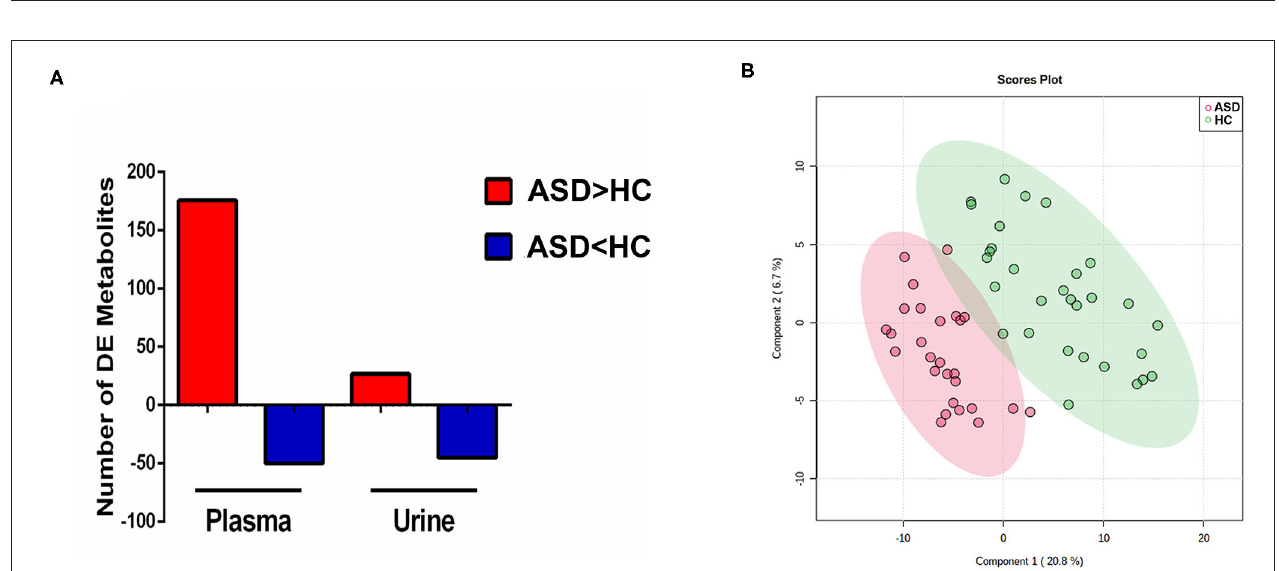
FIGURE 2 | Discriminating metabolites and partial least squares discrimination analysis (PLS-DA). (A) Number of discriminating (DE) metabolites between groups in plasma and urine samples. (B) Partial least squares discrimination analysis (PLS-DA) score plot in ASD (red) and HC (blue) boys. Each point represents the metabolome score of a single individual. The shaded areas indicate the 95%confidence ellipse regions for each